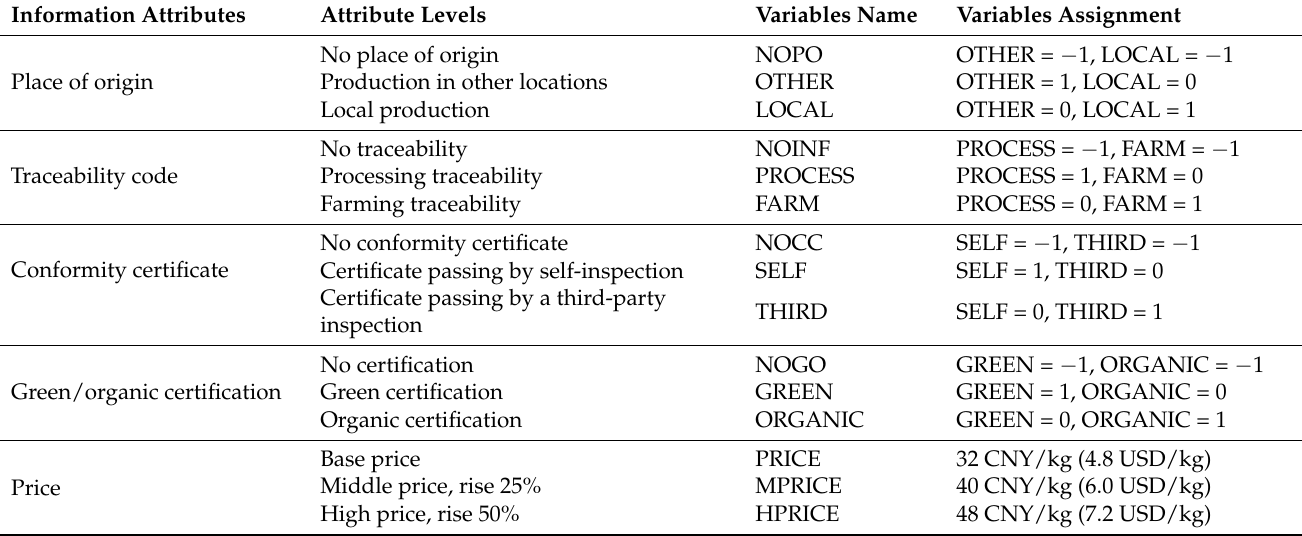
Table 1. Attributes design and variables definition of Choice